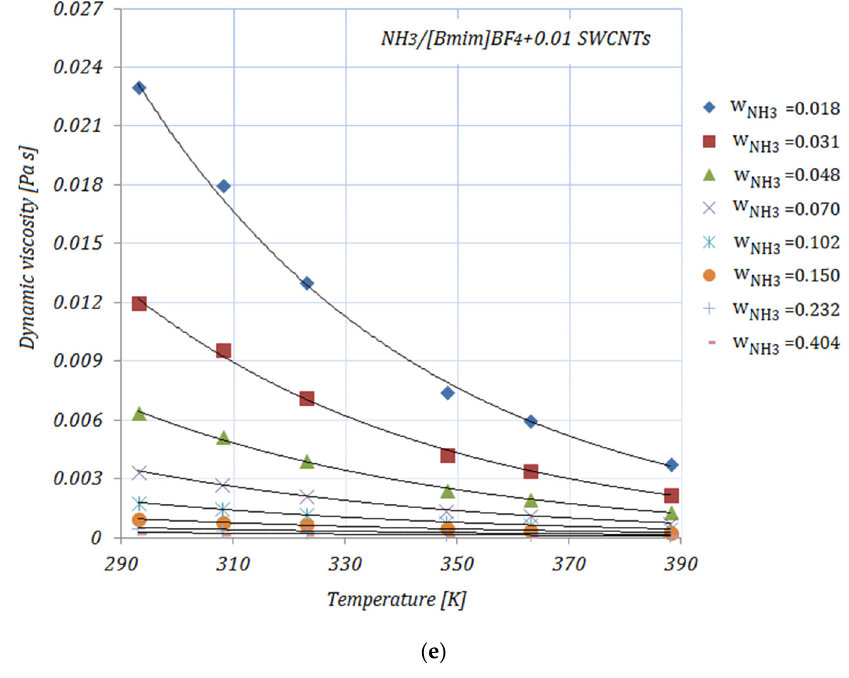
Figure 2. - Solution dynamic viscosity. Figure 2. Solution dynamic viscosity. The dynamic viscosity values are correlated by means of an exponential equation as Table 5. Coefficient values a , b , and R 2 obtained by fitting Equation